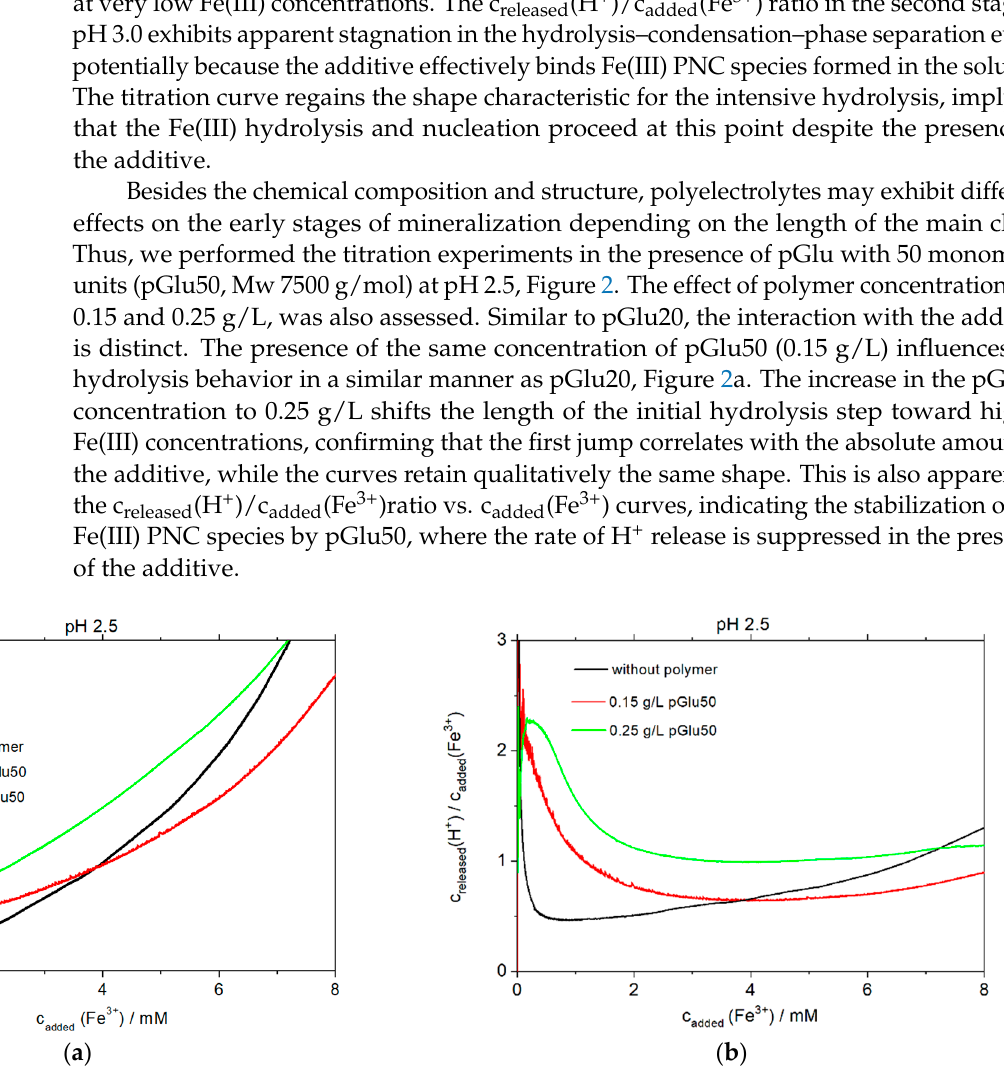
Figure 2. ( a ) Titration curves at pH 2.5 without the polymer and in the presence of pGlu50 at 0.15 and 0.25 g/L; ( b ) the corresponding c released (H + )/c added (Fe 3+ ) ratio vs. c added (Fe 3+ ) curves.